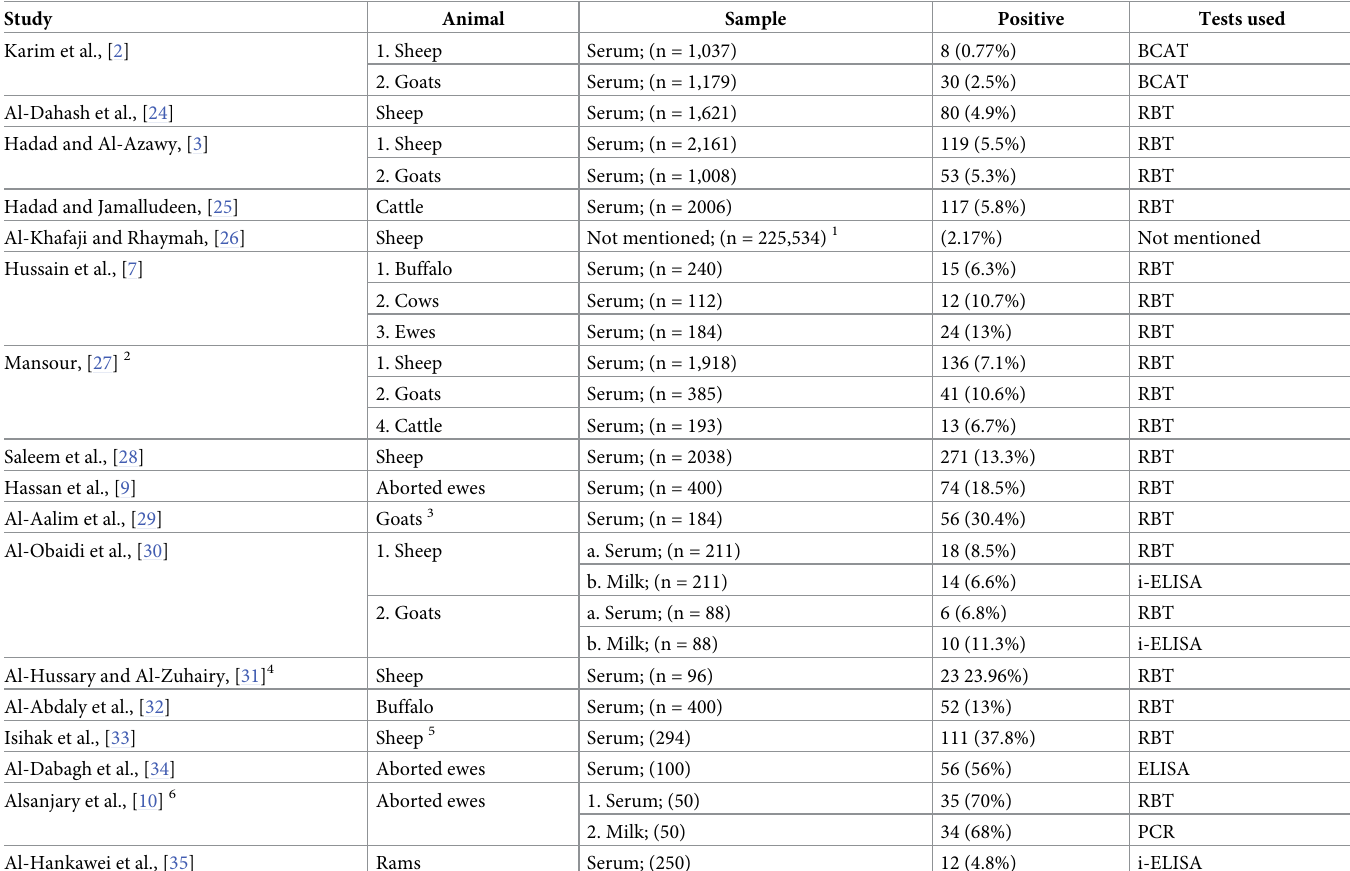
Table 1. Qualified studies that examined brucellosis in different food-producing animals in Mosul, Iraq, with main objective: Reporting the prevalence of the disease. Study Animal Sample Positive Tests